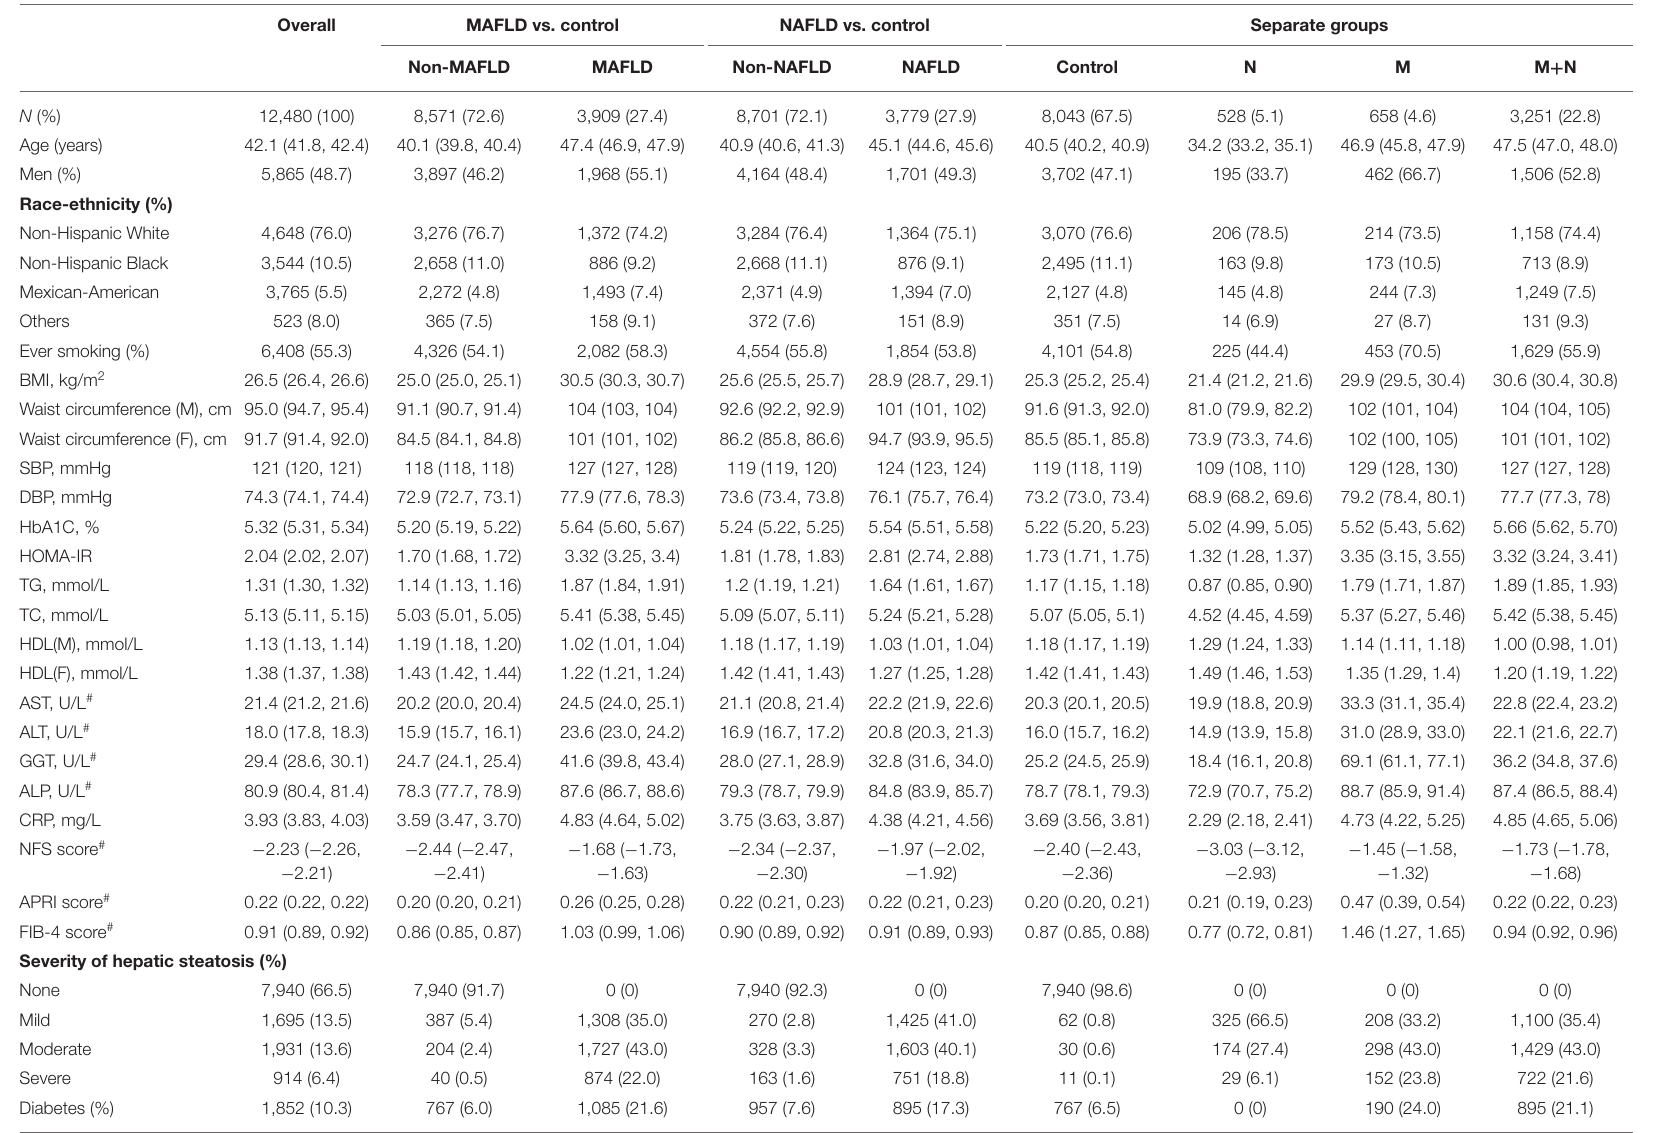
TABLE 1 | The characteristics of the participants ( N = 12,480) * . Overall MAFLD vs. control NAFLD vs. control Separate groups Non-MAFLD MAFLD Non-NAFLD NAFLD